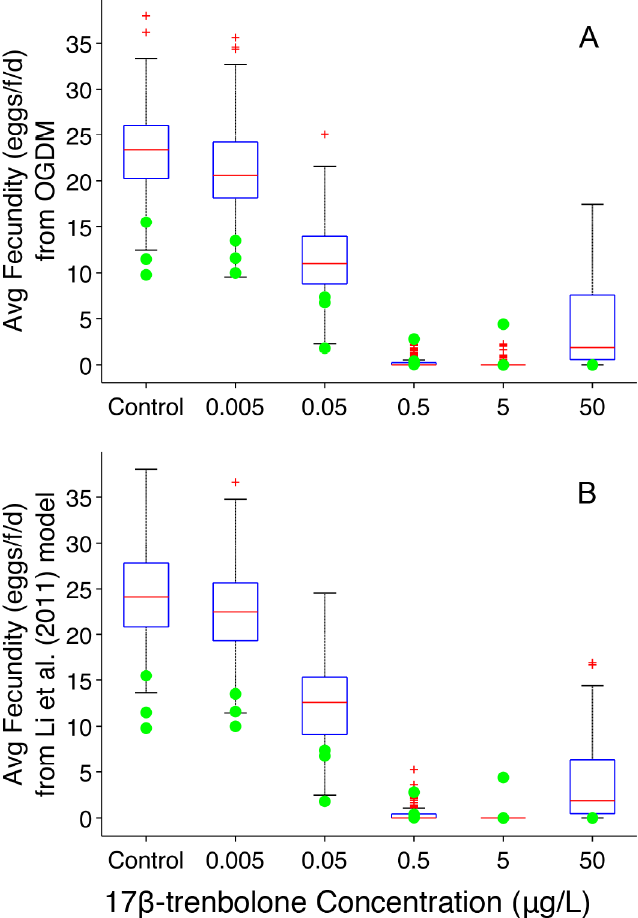
Fig 1. Predicted Average Fecundity for Fathead Minnows Exposed to 17 β -trenbolone (group spawning design). (A) OGDM model predictions. (B) MCSim oocyte growth dynamics model predictions. Filled circles represent experimentally observed values [18]. Boxplots represent 150 model-simulated values (three groups of fish per treatment simulated 50 times per group). In the boxplots, the red line represents the median, lower and upper edges of the box are the 25 th and 75 th percentiles, respectively, lower and upper whiskers denote the most extreme values that are not outliers (~2.7 σ or 99.3 percentile for normally distributed values), and the red + symbol represents